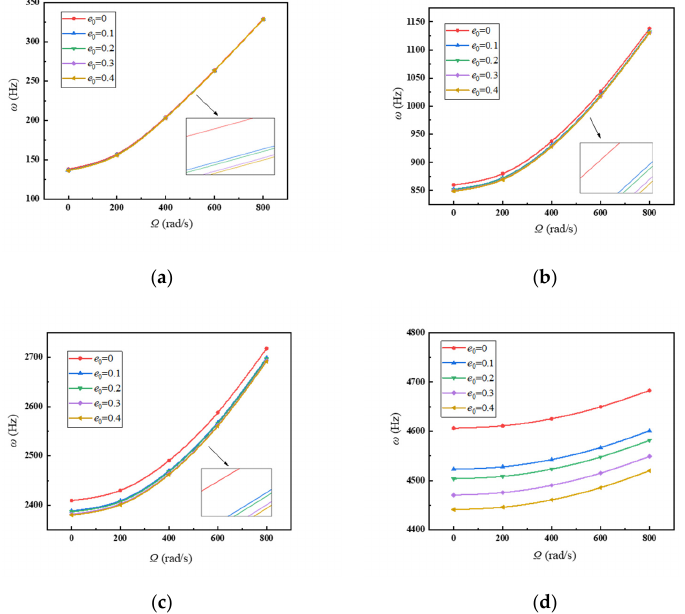
Figure 7. Variations of frequencies with rotating speed under different porosity coefficients. ( a ) First frequency; ( b ) second frequency; ( c ) third frequency; ( d ) fourth frequency. Variations of the first four frequencies with the rotating plate in the case of different ratios of surface-thickness and core-thickness are exhibited in Figure 8. As the ratios continue to increase, frequencies of the plate increase significantly. It tells those thicker surfaces give a hand in enhancing the structural stiffness.